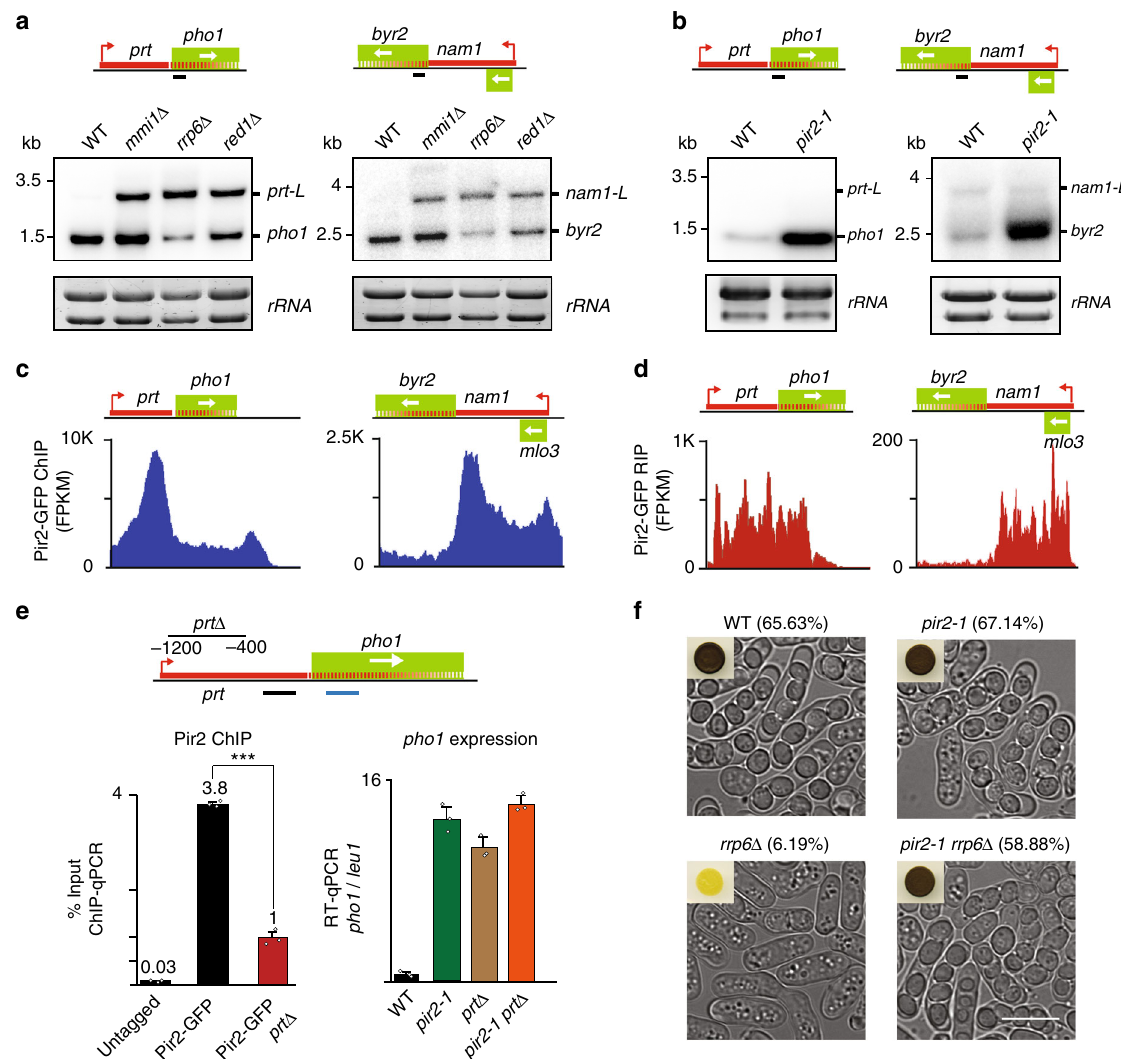
Fig. 1 Pir2 is required for lncRNA-mediated repression of neighboring genes. a , b Northern blot analysis of transcripts produced from the pho1 and byr2 loci. The black line indicates the position of the radioactive probe. Ribosomal RNA was used as a loading control. Cells were grown in YEA medium. Note that longer exposures were used to detect prt-L and nam1-L transcripts in ( a ). As a result, pho1 and byr2 bands in WT lanes are darker in ( a ) as compared to ( b ). c ChIP-seq analysis of Pir2-GFP enrichment at pho1 and byr2 loci. Source data are provided as a Source data fi le. d RIP-seq analysis of Pir2-GFP at pho1 and byr2 loci. e ChIP-qPCR analysis of Pir2-GFP (left panel). The region deleted from the prt lncRNA ( prt Δ ) is indicated. The ampli fi ed region is indicated by a black line. Data are presented as mean values± SD for n = 3 biologically independent samples. Student ’ s t -test (two-tailed) was used to calculate p -value. Between Pir2-GFP and Pir2-GFP prt Δ , p = 0.0009 (*** p < 0.001). RT-qPCR analysis of the pho1 gene (right panel). Transcript levels were normalized to the leu1 control. The ampli fi ed region is indicated by the blue line. Data are presented as mean values ± SD for n = 3 biologically independent samples. Mean data distribution is represented by white circles. f Representative DIC images of homothallic (h 90 ) WT and mutant strains. The sporulation frequency is indicated as a percentage ( n > 1000). Insets show colonies stained with iodine vapor. The white scale bar represents 10 µ